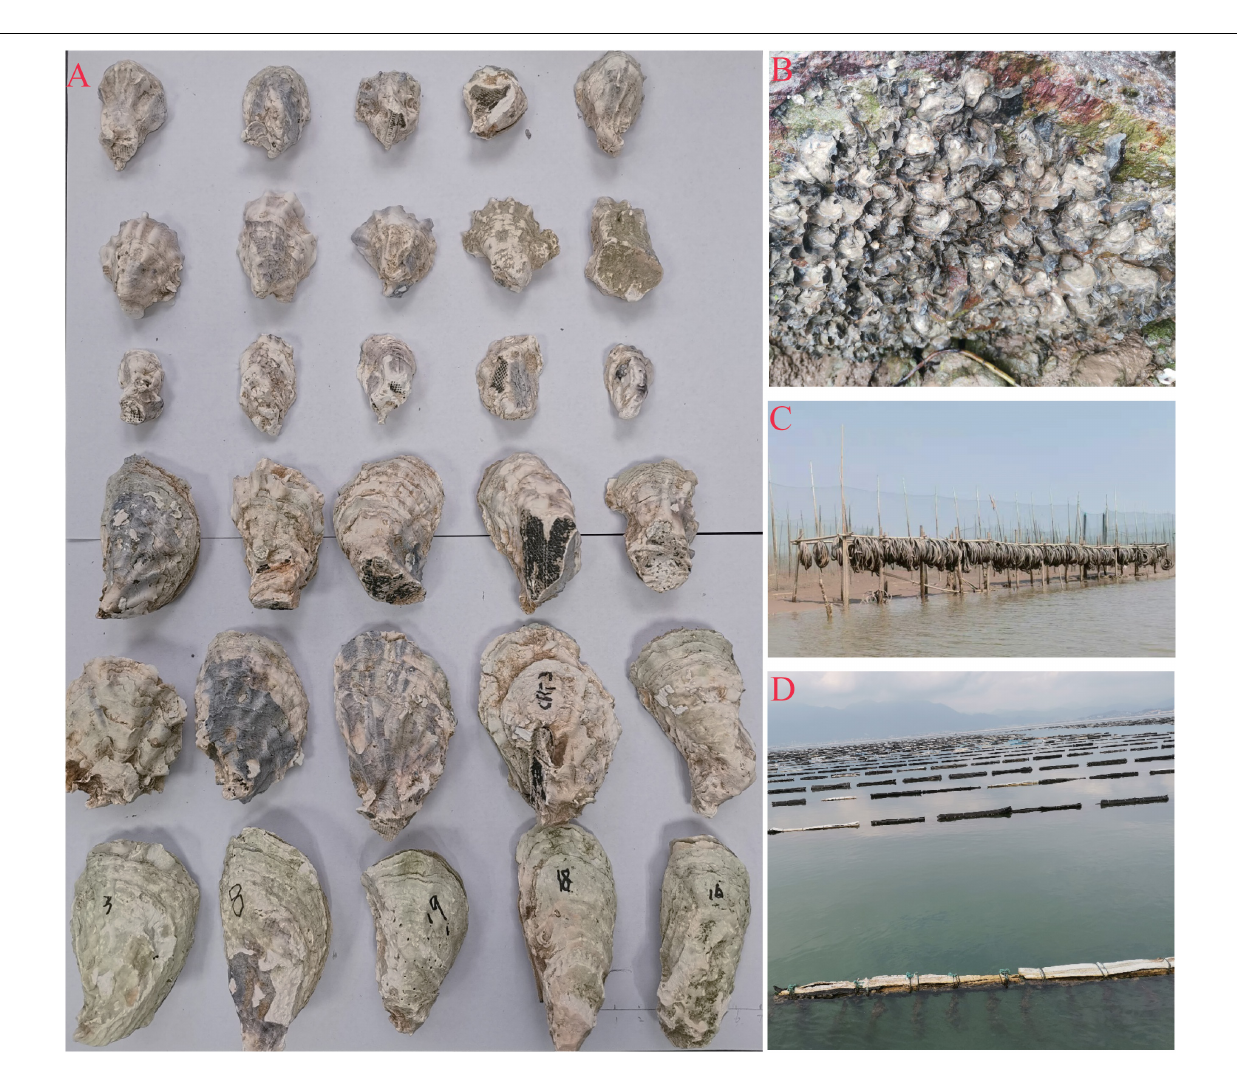
Frontiers in Marine Science |